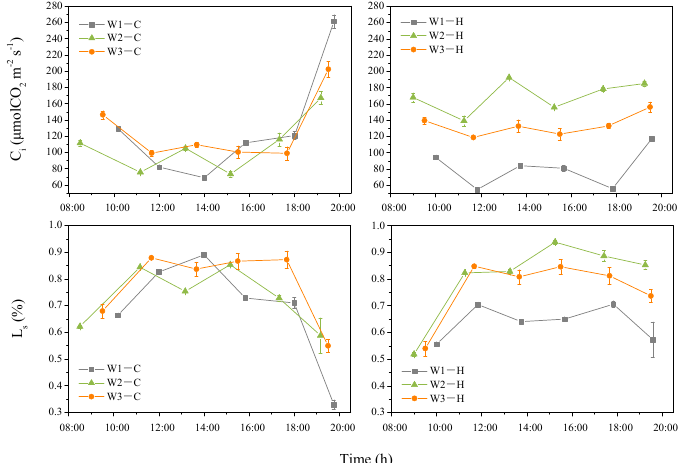
Figure 6. Differences in the intercellular CO 2 concentrations (C i ) and stomatal limitations (L s ) of C. mongolicum ( C ) and H. ammodendron ( H ) in the low (W1), medium (W2) and high (W3) irrigation amounts.